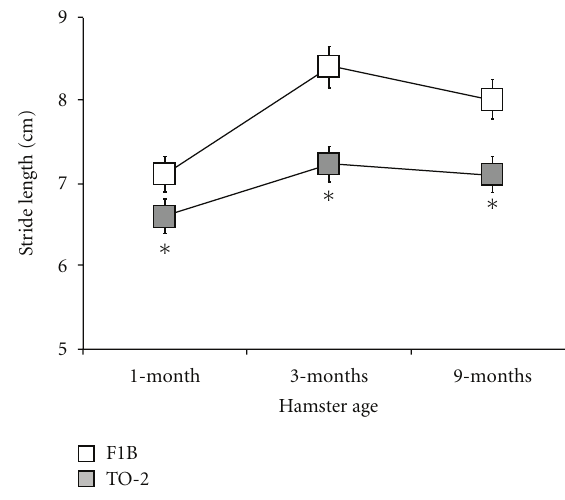
Figure 5: Gait disturbances were evident in TO-2 dystrophic hamsters at 1-month of age. Stride length, for example, was consistently significantly shorter in the delta-sarcoglycan-deficient dystrophic hamsters compared to F1B control hamsters at 1-month, 3-months, and 9-months of age. ∗ P < . 05, TO-2 compared to F1B.